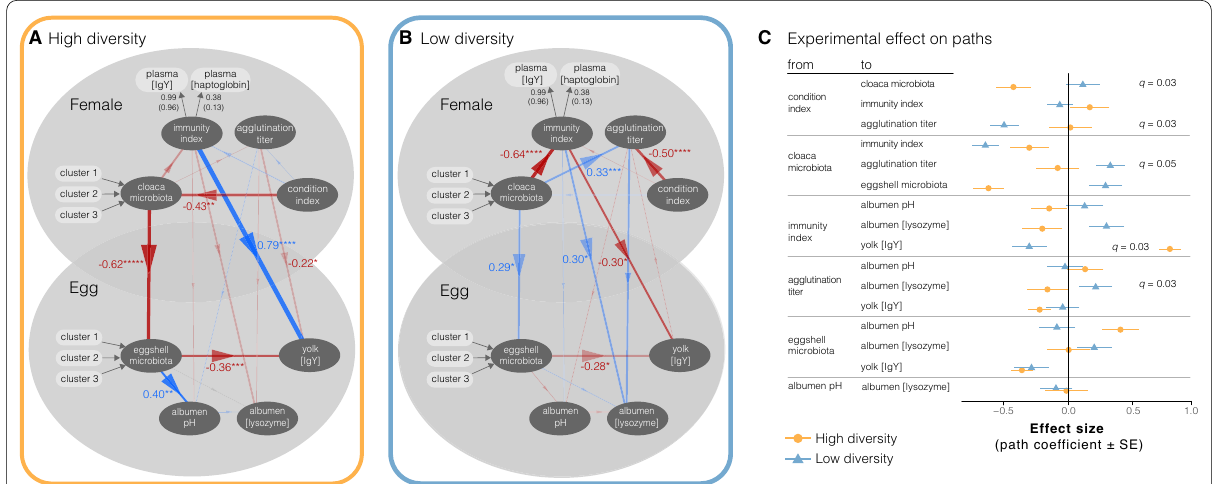
Fig. 4 PLS-PM predictions link environmental and maternal microbiota to egg immune function. PLS-PM structural model representations. ( A , B ) depict predicted path coefficients that were extracted from the global model for experimental microbial environments with A High diversity and B Low diversity. C The experimental treatment effect on path coefficients was assessed with a bootstrap procedure and a t -test, where effects with FDR q < 0.1 were considered significant. A , B Dark grey ellipses depict (uni- or multivariate) latent variables and light grey rectangles represent manifest variables of either reflective or formative indicators of the latent variables. Colored arrows represent the path predictions (blue red negative), line weight is proportional to the effect size (arrow labels); asterisks denote the probability that path coefficient is not zero: * = P < 0.05, ** P < 0.01, *** P < 0.001, **** P <